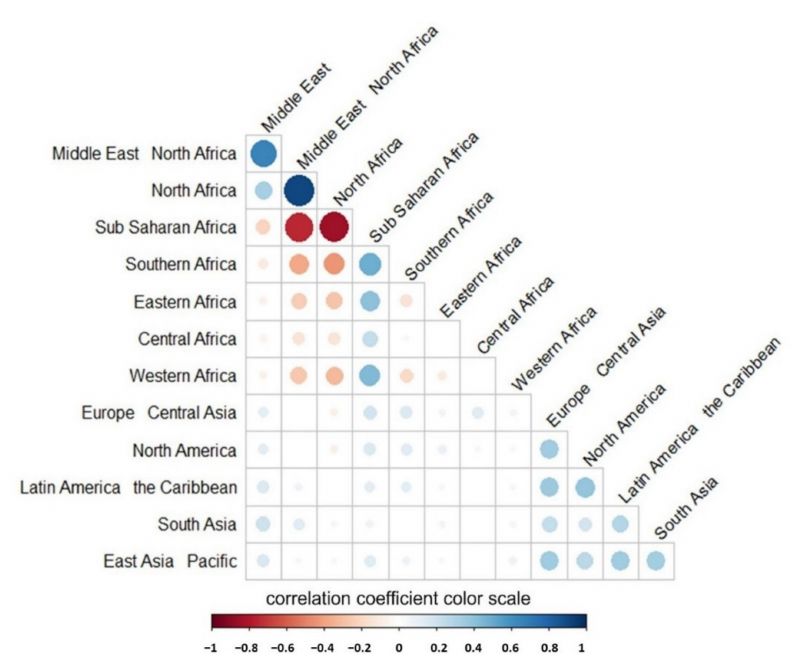
Figure 2. Correlation heatmap denoting the strength of COVID-19 research collaboration networks between African and other institutions. The diameter of the circles and color codes represent the Spearman value of correlation coefficients. The larger (or the lower) the value, the higher (or the lower) the collaboration strength between regions.